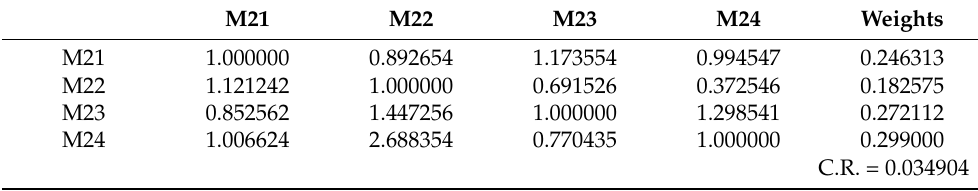
Table 11. Defuzzified pair-wise comparative matrix with parameter local weight for audit source location.